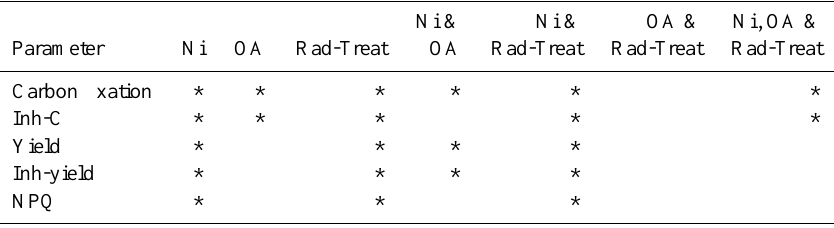
Table 1. Interactive effects among NO − concentrations, CO 2 levels and radiation treatments. Two or three way ANOVA analysis of individual 3 and interactive effects among NO − concentrations, CO 2 levels and radiation treatments. The asterisks indicate significance at P< 0 . 05. Where 3 “Ni” indicates nitrate, “OA” CO 2 / pH, “Rad-Treat” radiation treatments, “Inh-C” inhibition of carbon fixation and “Inh-yield” inhibition of yield.